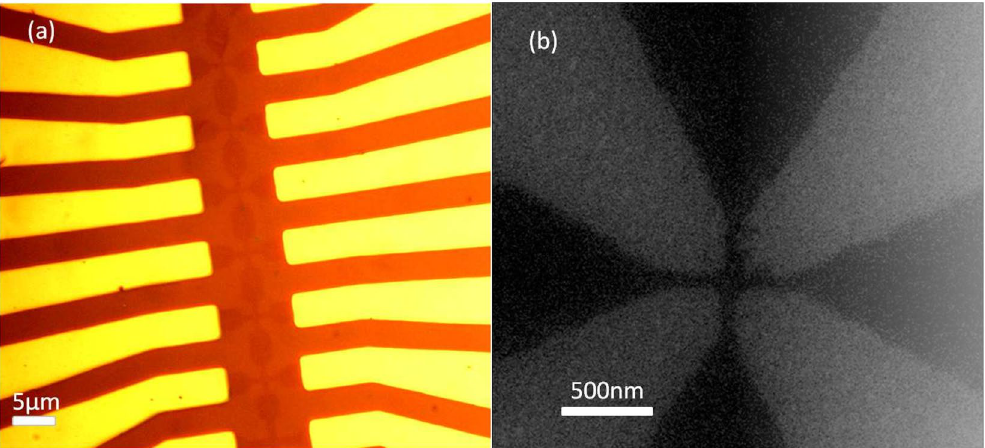
Figure 9. ( a ) Optical micrograph showing part of a fabricated Hall cross array (darker brown) and the inner Cr/Au contact leads (gold). ( b ) An SEM image of an 85 nm CVD graphene Hall